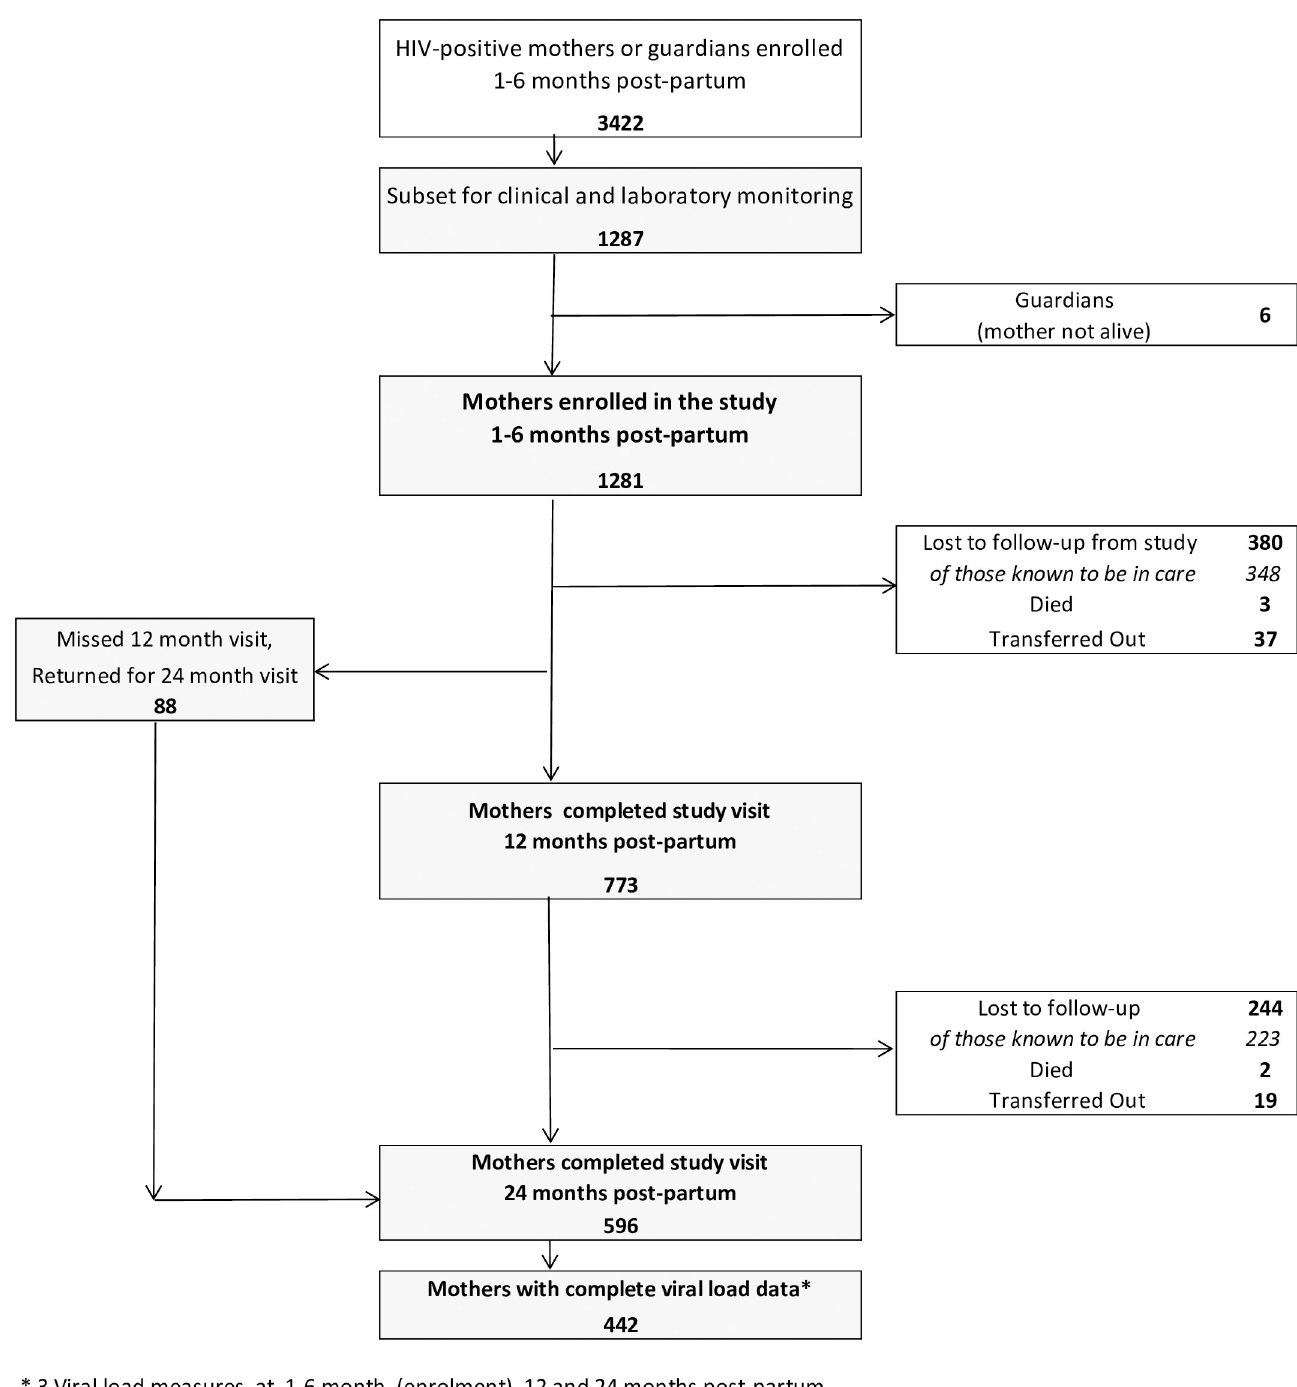
Fig 1. Mothers enrolled, followed and retained in the study up to 24 months